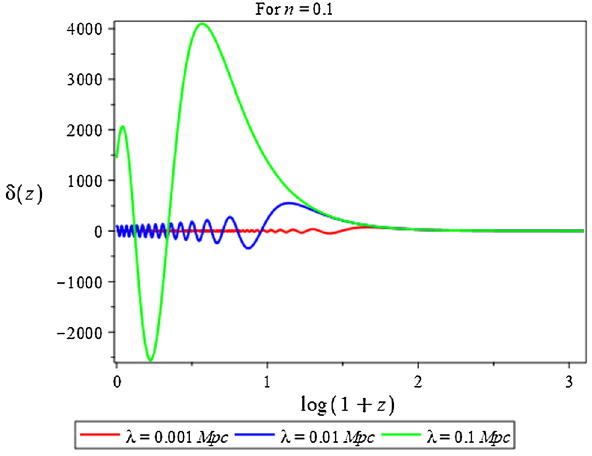
Fig. 13 δ( z ) versus z for f ( T ) = T + μ T 0 ( T / T 0 ) n for short- wavelength mode for different λ at n = 0 . 1. We use Ω r = 4 . 48 × 10 − 5 for plotting